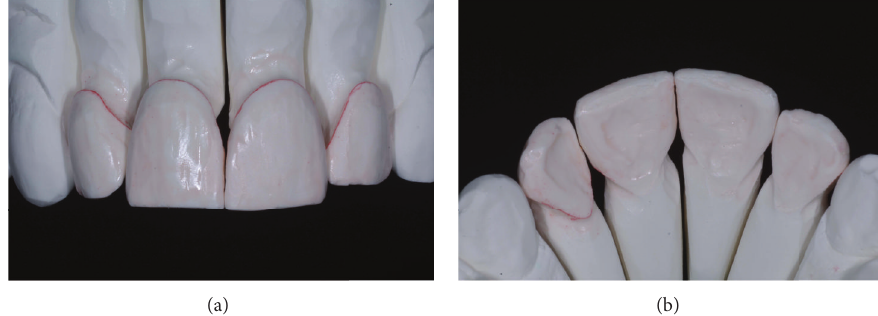
Figure 11: (a)-(b) Buccal and palatal view of the upper ditched master cast.